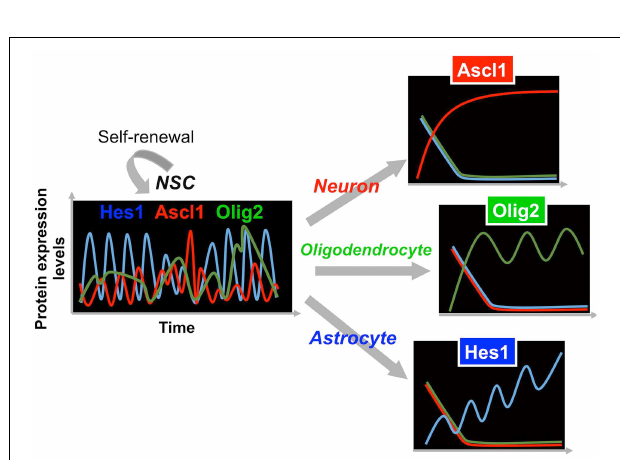
FIGURE 2 | Oscillatory expression of bHLH factors in NSCs. NS cell cultures were prepared from Venus-Hes1 knock-in mice (A) , Venus-Ascl1 BAC Tg mice (B) , or mCherry-Olig2 BAC Tg mice (C) . (A–C) Examples of